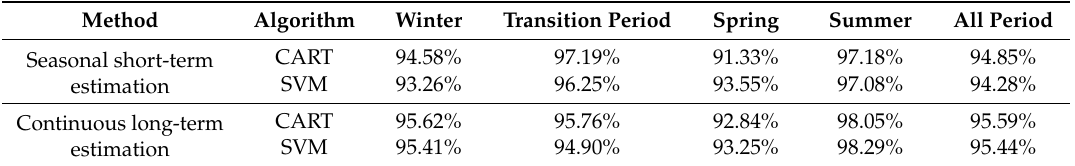
Table 10. Comparison of seasonal and overall accuracy between short-term and long-term occupancy estimation methods.